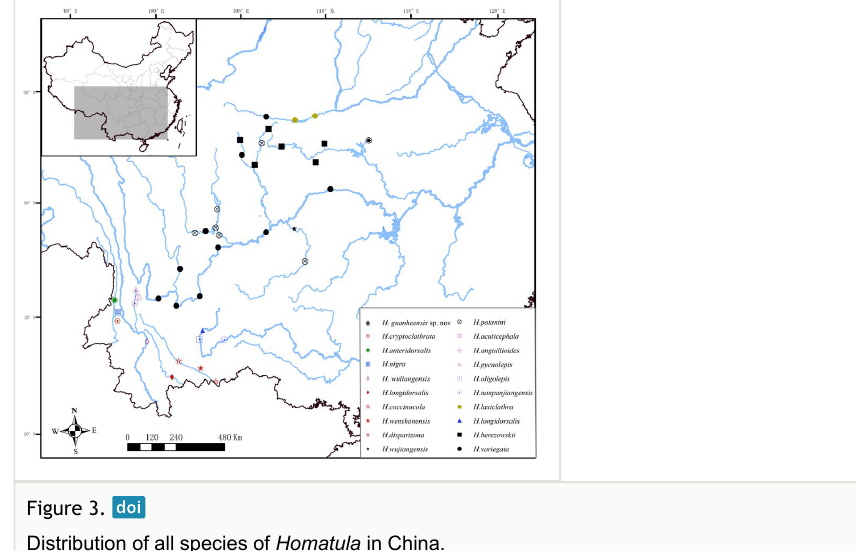
Distribution of all species of Homatula in